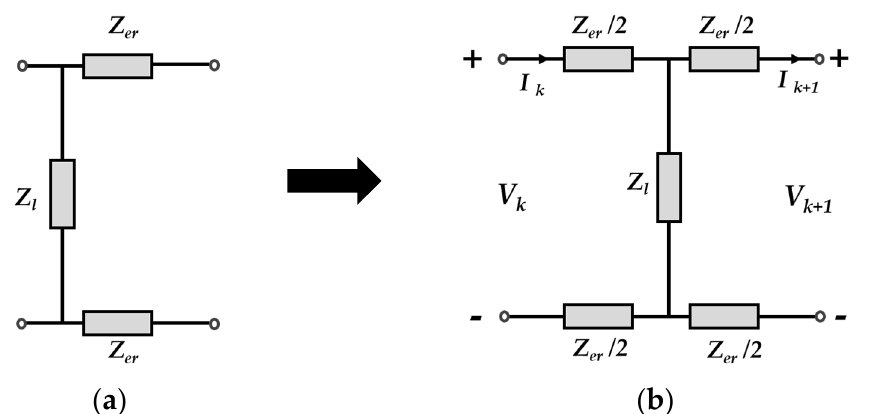
Figure 5. The block diagrams of: ( a ) The unit segment of a conventional birdcage RF coil; ( b ) Two port equivalent circuit of the unit segment.